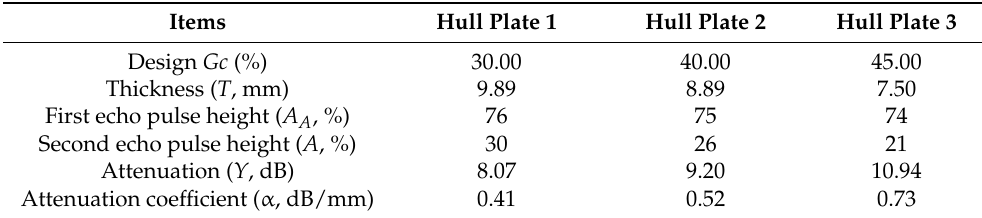
Figure 5. Ultrasonic A-scan analysis results for each type of plate in the Gc variation group: ( a ) design Gc 30%; ( b ) design Gc 40%; and ( c ) design Gc 45%. Table 3. Characteristics of and attenuation analysis results for each plate in the Gc variation group.